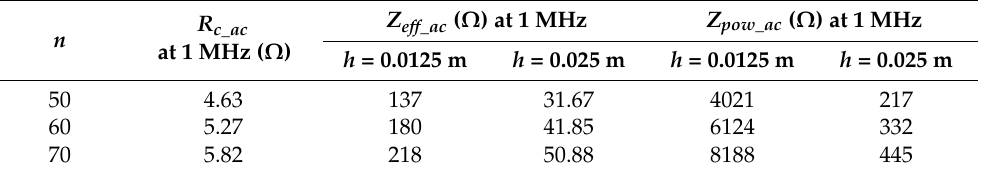
Table 5. Calculated circuit parameters for r = 0.025 m (with skin effect).